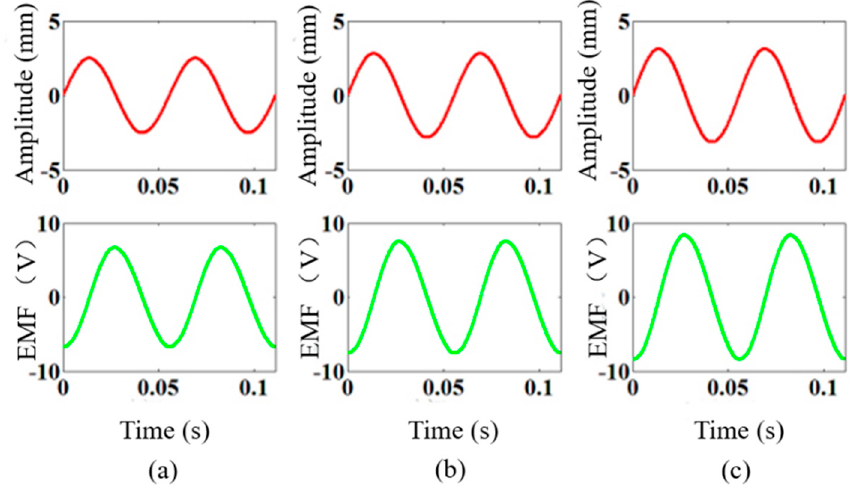
Figure 11. Effect of the excitation amplitude on the EMF:( a ) 2.5 mm; ( b ) 2.8 mm; ( c ) 3.1 mm.